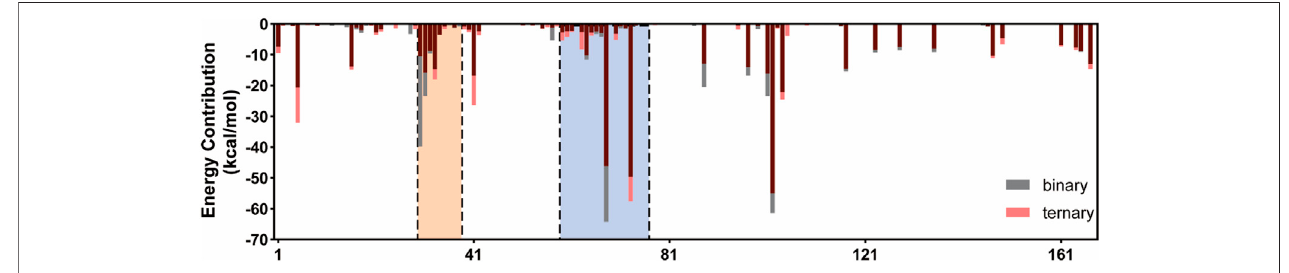
(cid:129) SOS cat complex.TheswitchIandswitchIIregionsofK-Ras4B G13D are